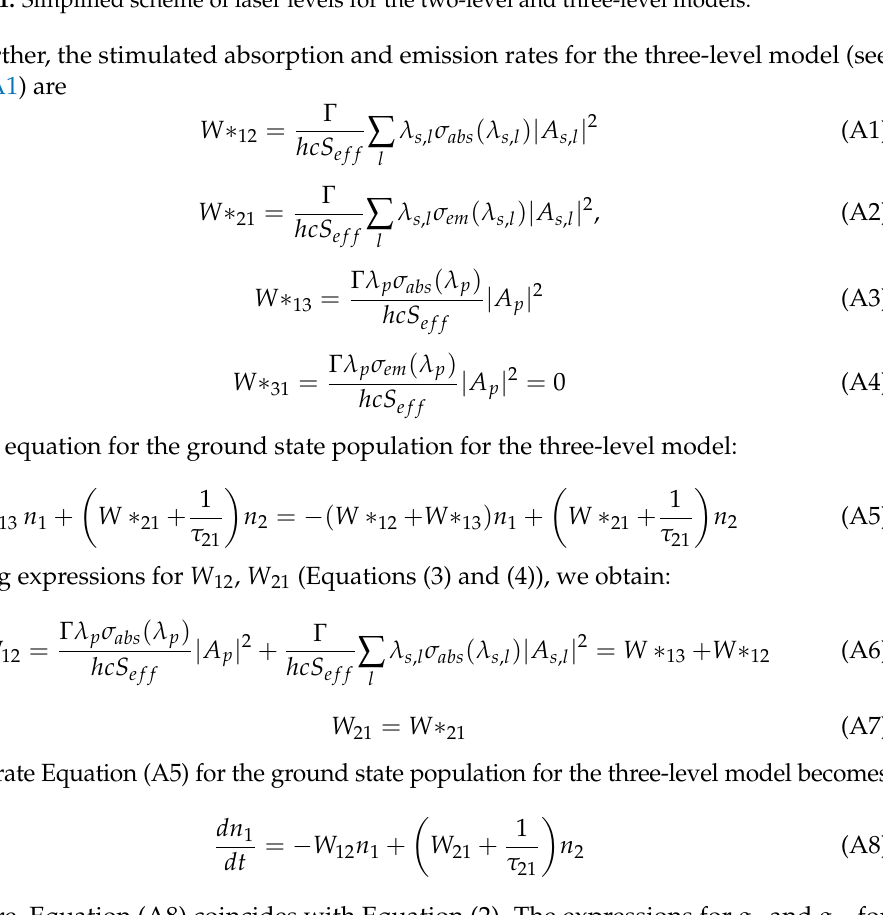
Figure A1. Simplified scheme of laser levels for the two-level and three-level models.